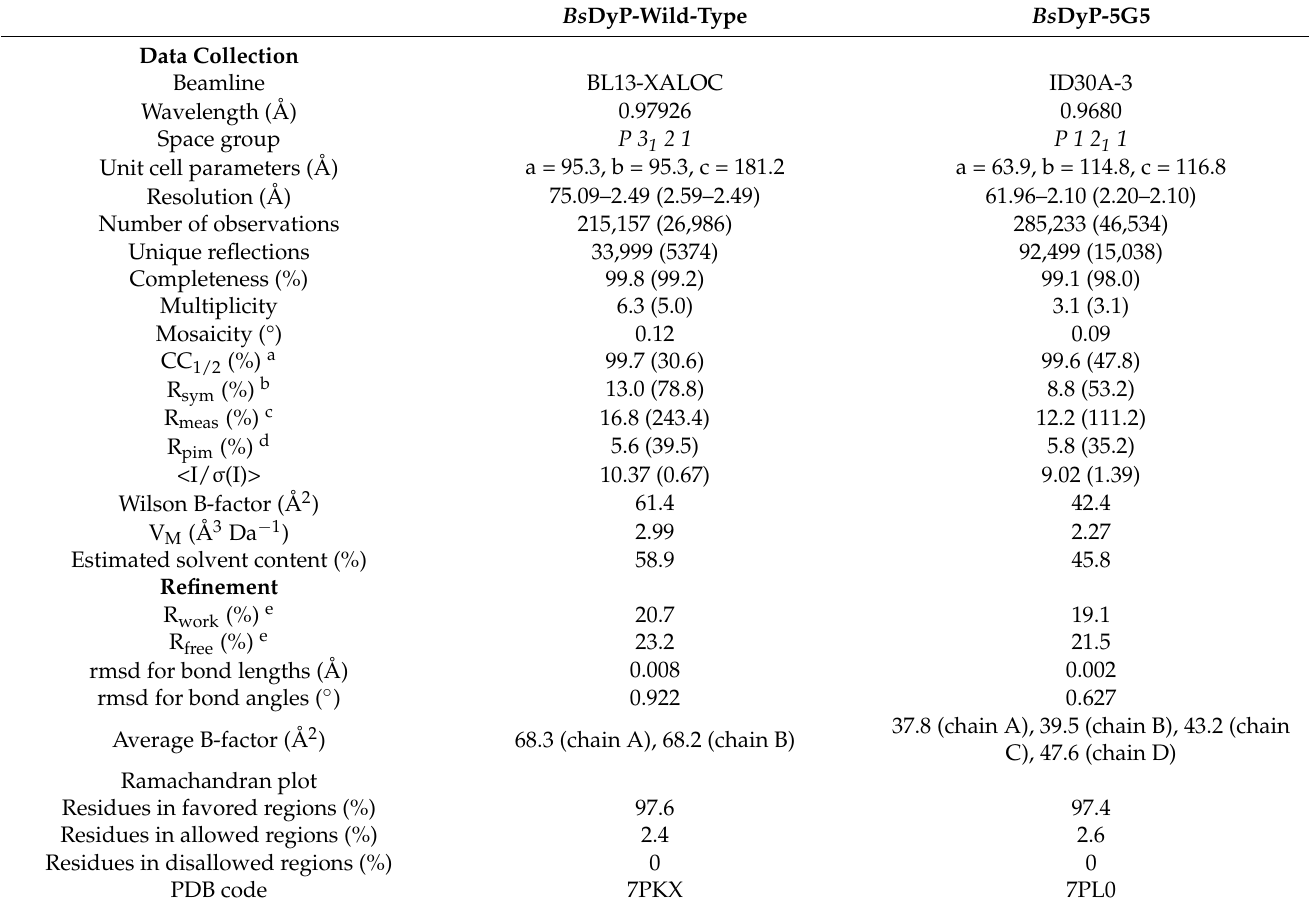
Table 4. X-ray data collection and refinement statistics. Values in parentheses belong to the highest resolution